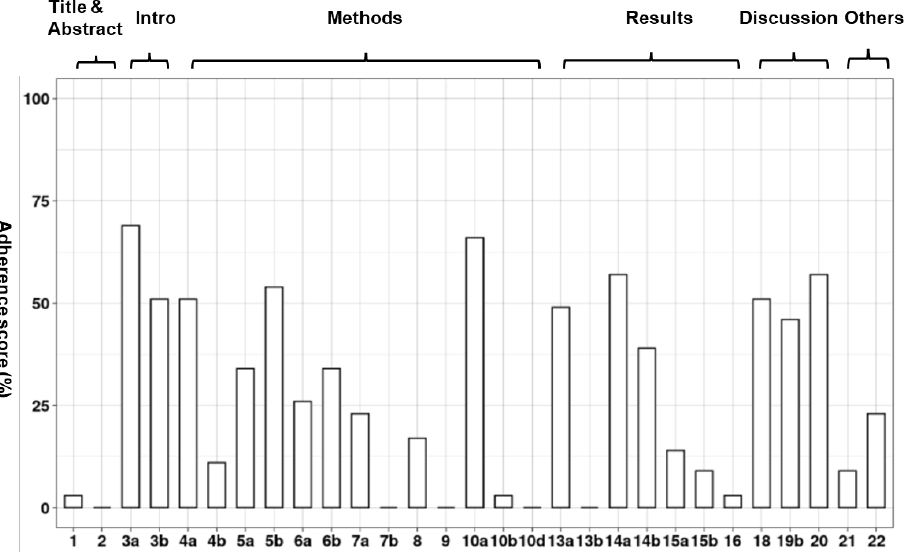
Figure 5. Overall adherence per TRIPOD